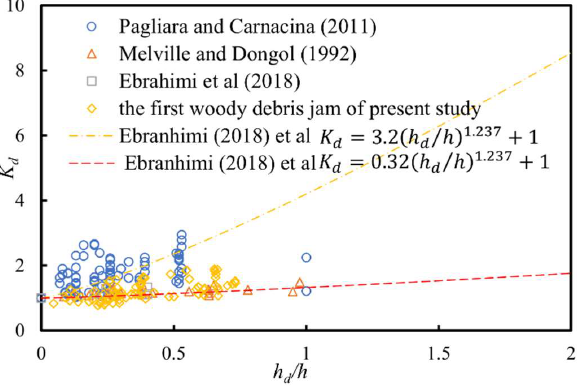
Figure 15. Comparison of the experimental data from [7,42,47] with the results from the present study.